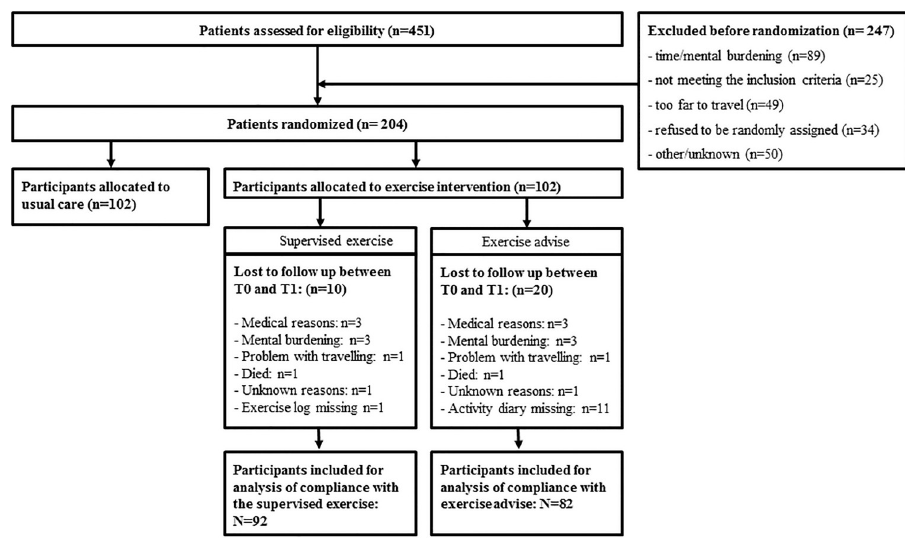
Fig 1. Flow of the participants through the